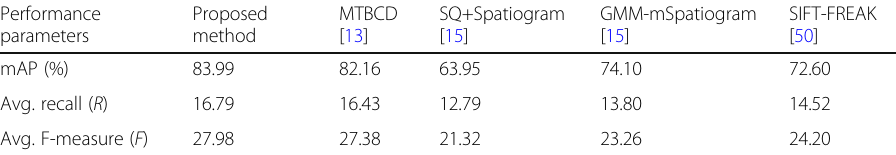
Table 4 Comparative analysis of competitive methods with a proposed method on the Corel 1500